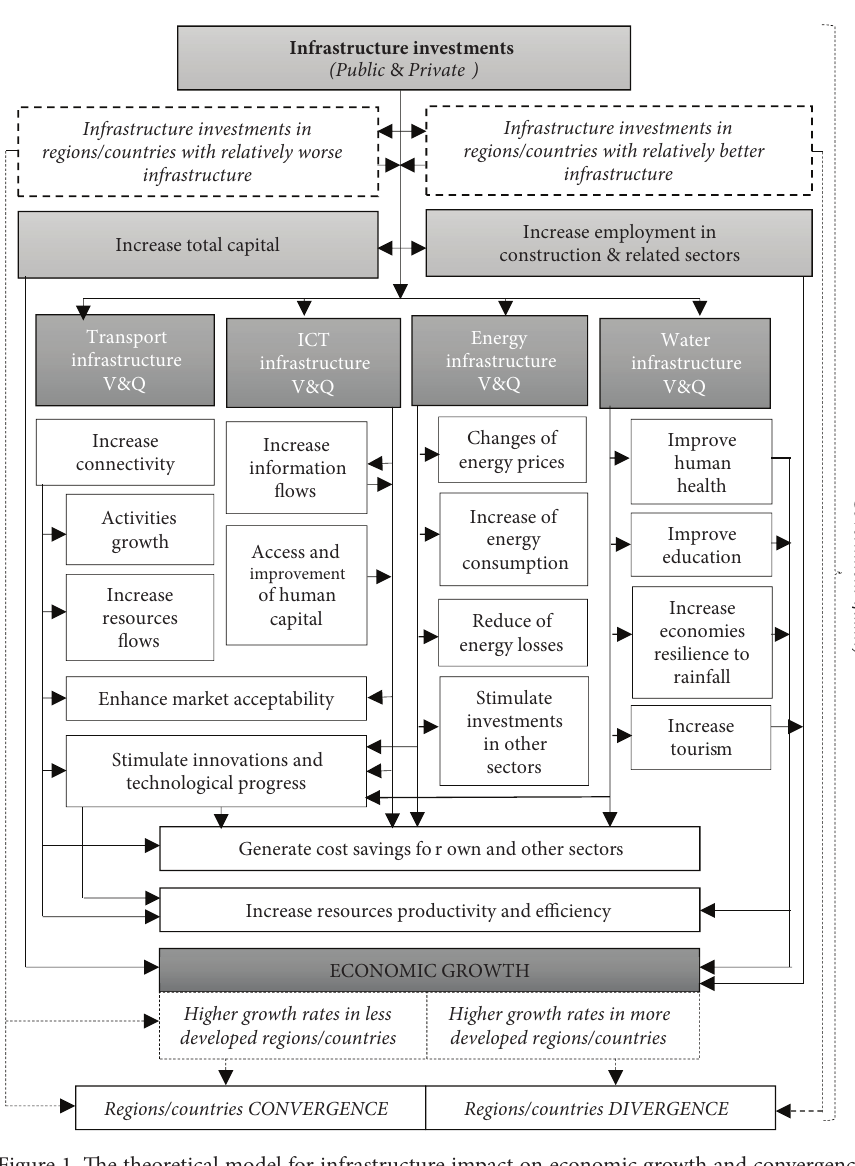
Figure 1. The theoretical model for infrastructure impact on economic growth and convergence (source: composed by the authors based on Sanctuary et al., 2005; Azevedo, 2014; Meersman & Nazemzadeh, 2017; Toader et al., 2018; Kyriacou et al., 2019; Elysia & Wihadanto, 2020; Wang et al., 2020b; Kallal et al., 2021,